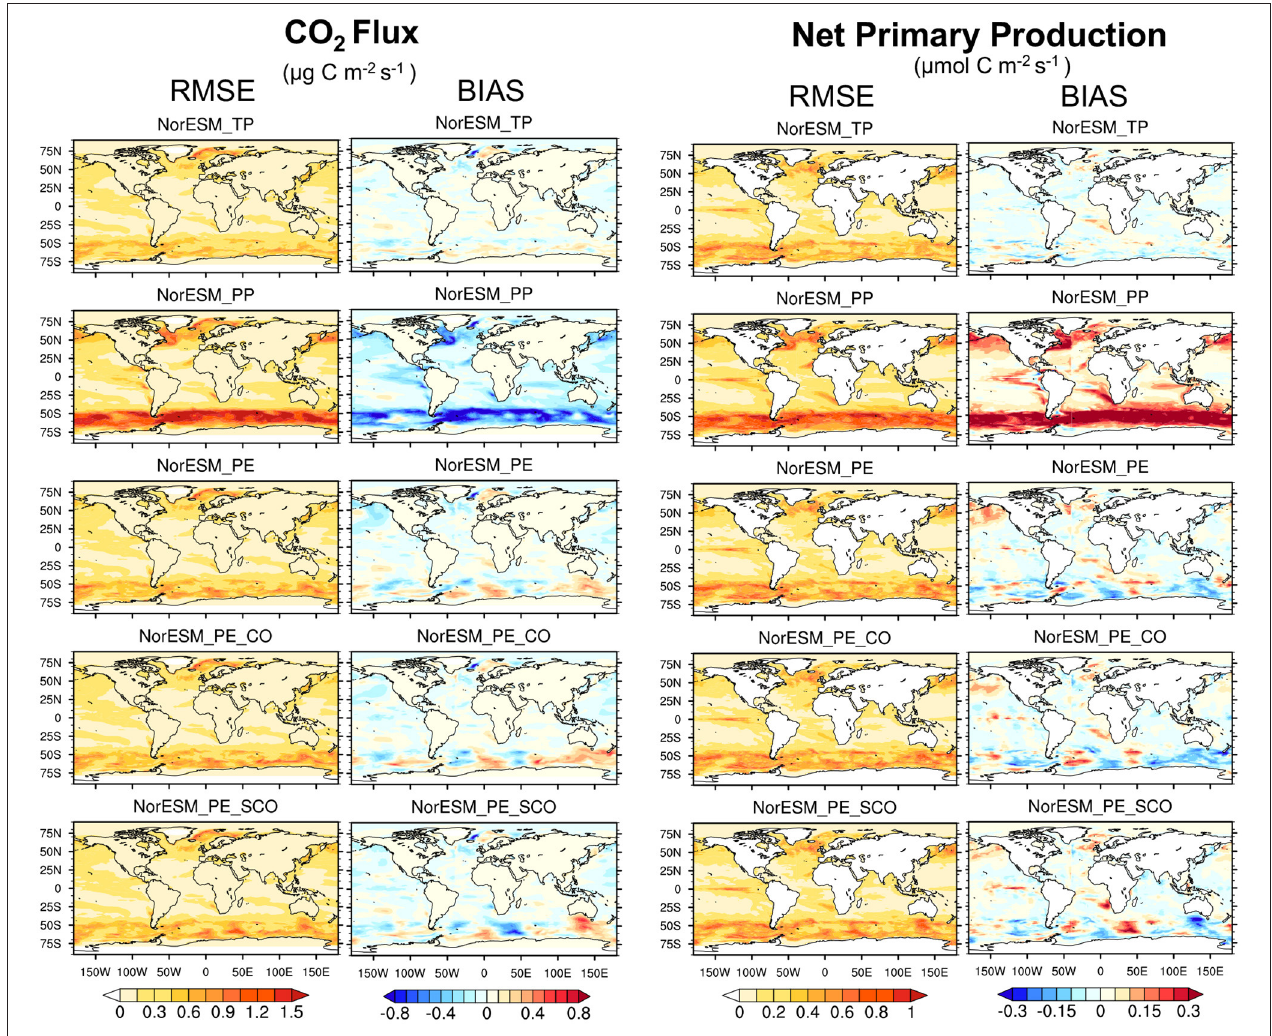
FIGURE 11 | Same as Figure 10 but for CO 2 flux (column-one and -two) and net primary production (column-three and -four).